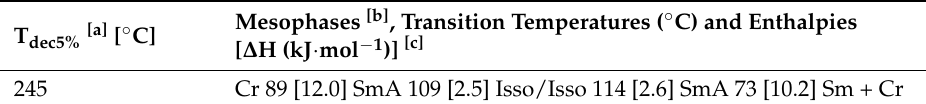
Table 1. Thermal and mesomorphic data for Zn_tpy.